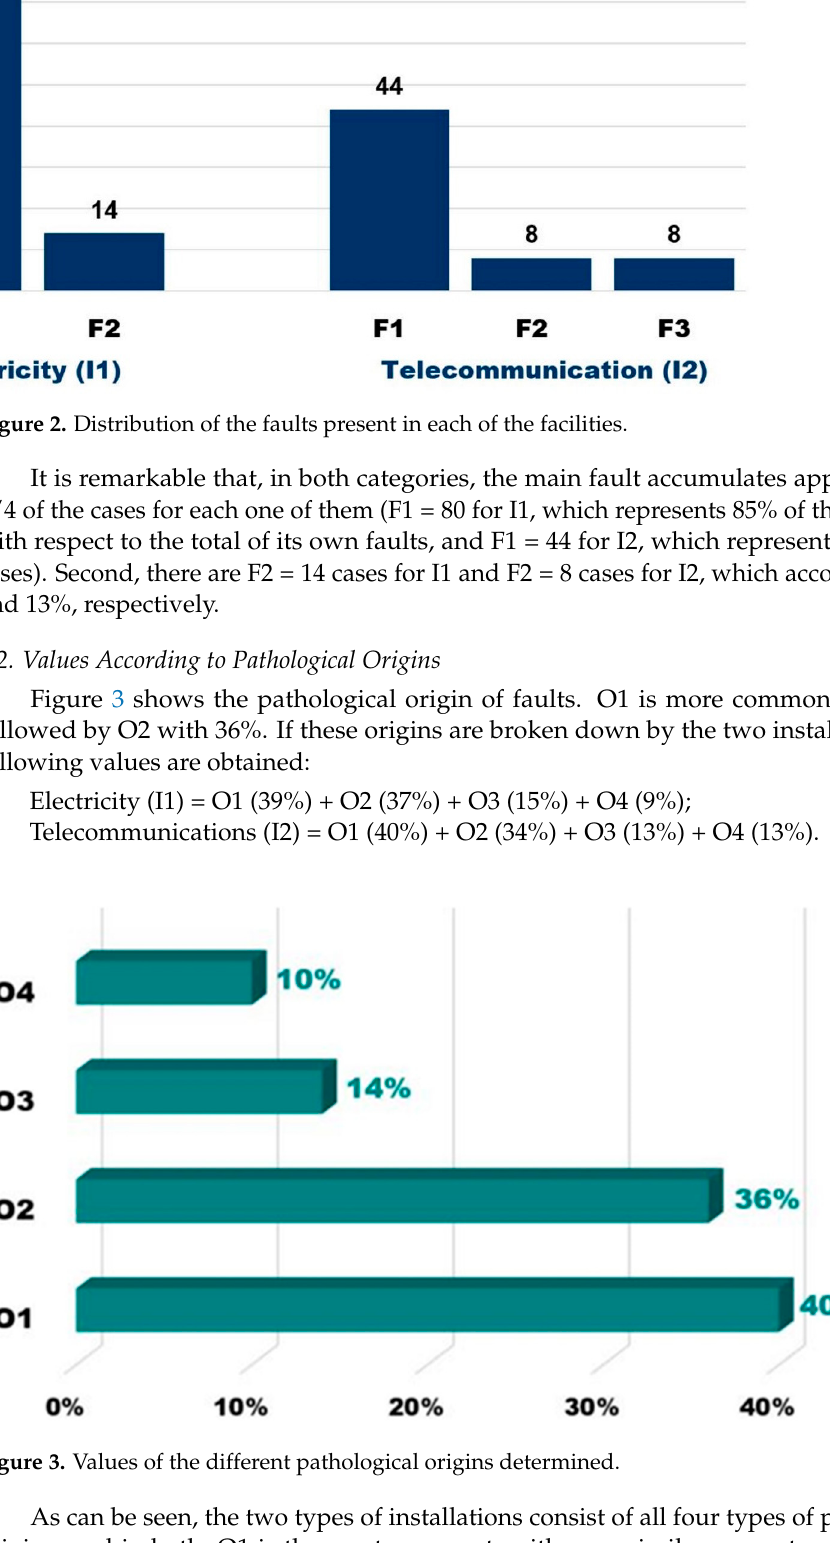
Figure 1. General percentages of the types of faults detected in the research.